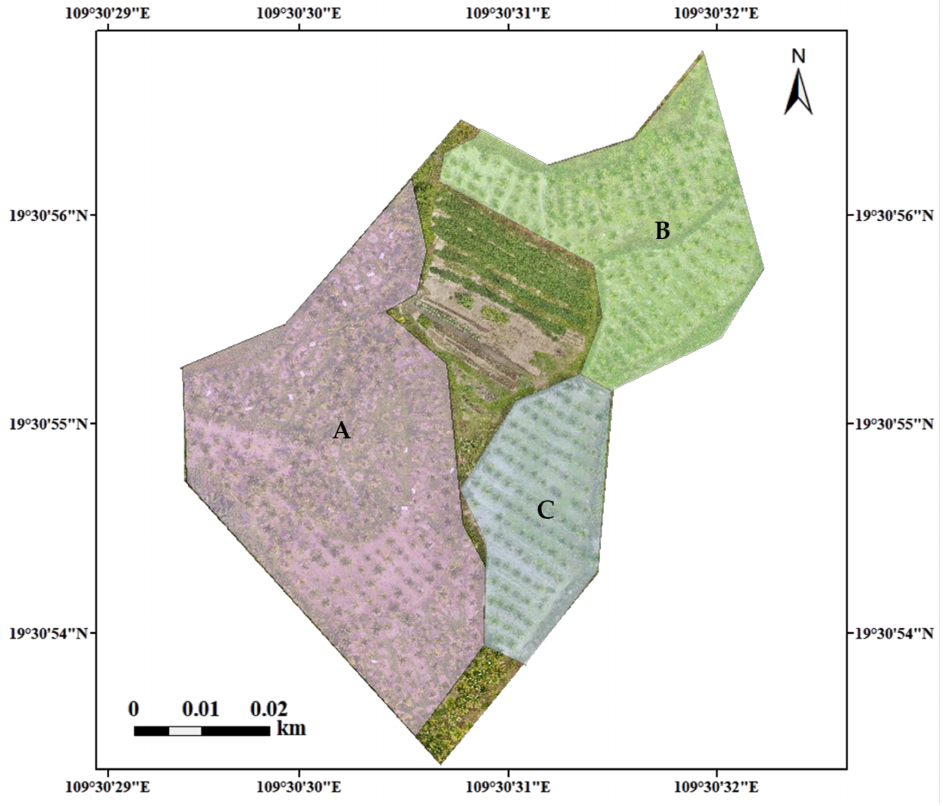
Figure 5. Areca zoning in the study